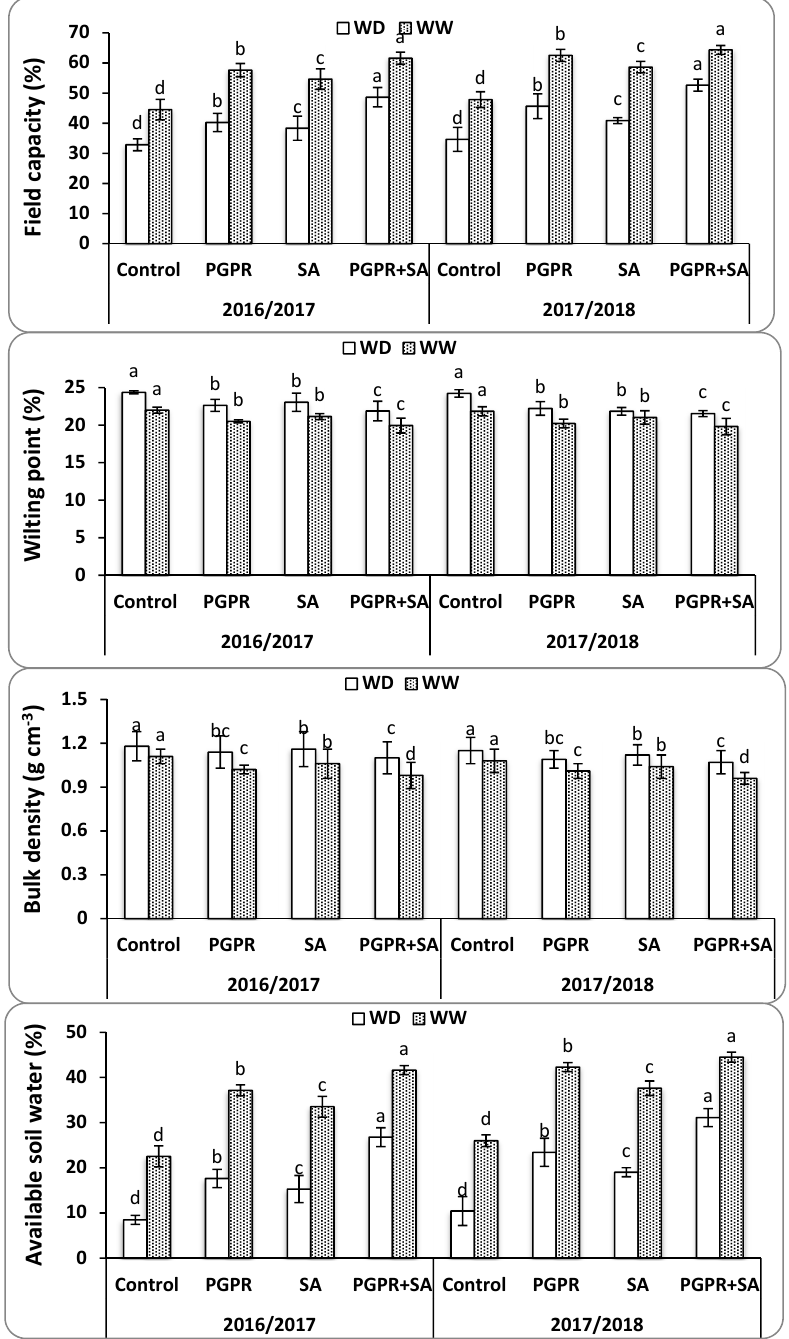
Figure 1. E ff ect of soil application by plant growth promoting rhizobacteria (PGPR), foliar application by salicylic acid (SA), and their combination on some soil moisture constants (FC = field capacity, WP